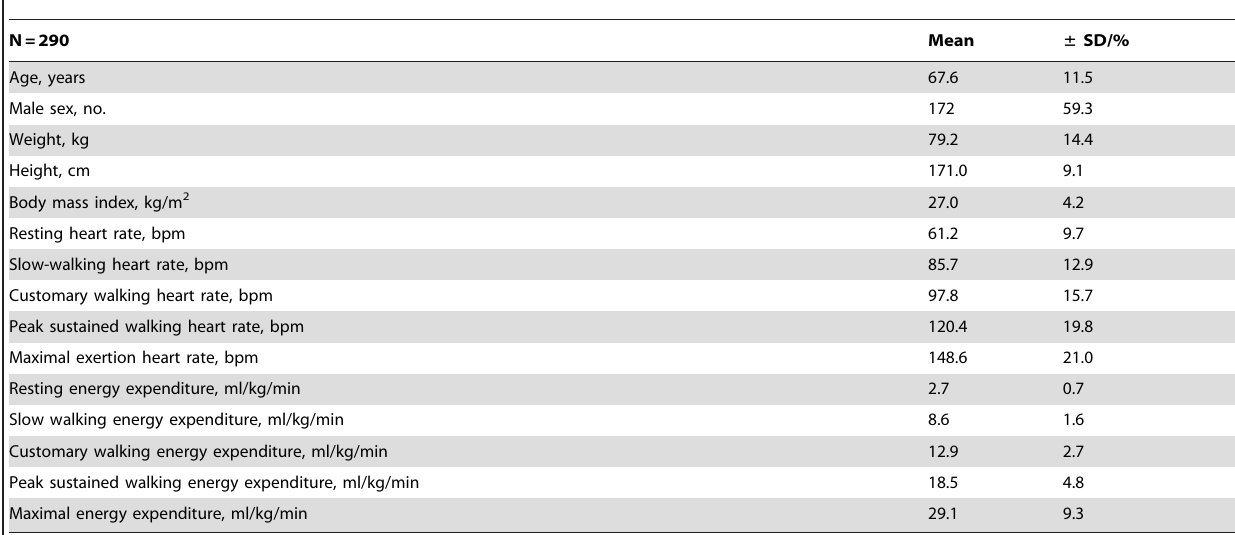
Table 1. Participant